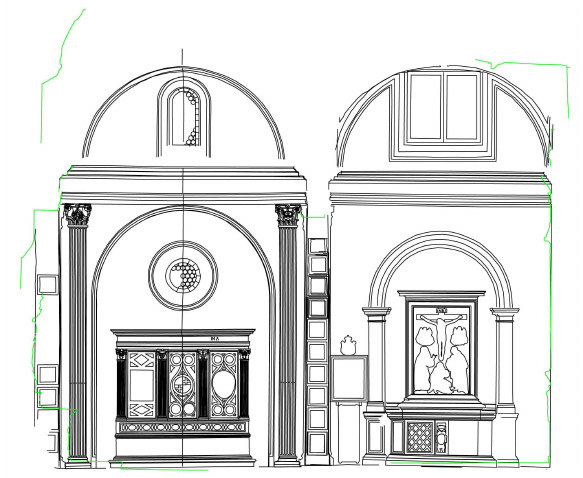
Figure 1. Italy, Naples, Monte Oliveto, Chapel of the Nativity, photogrammetric, M. Carpiceci